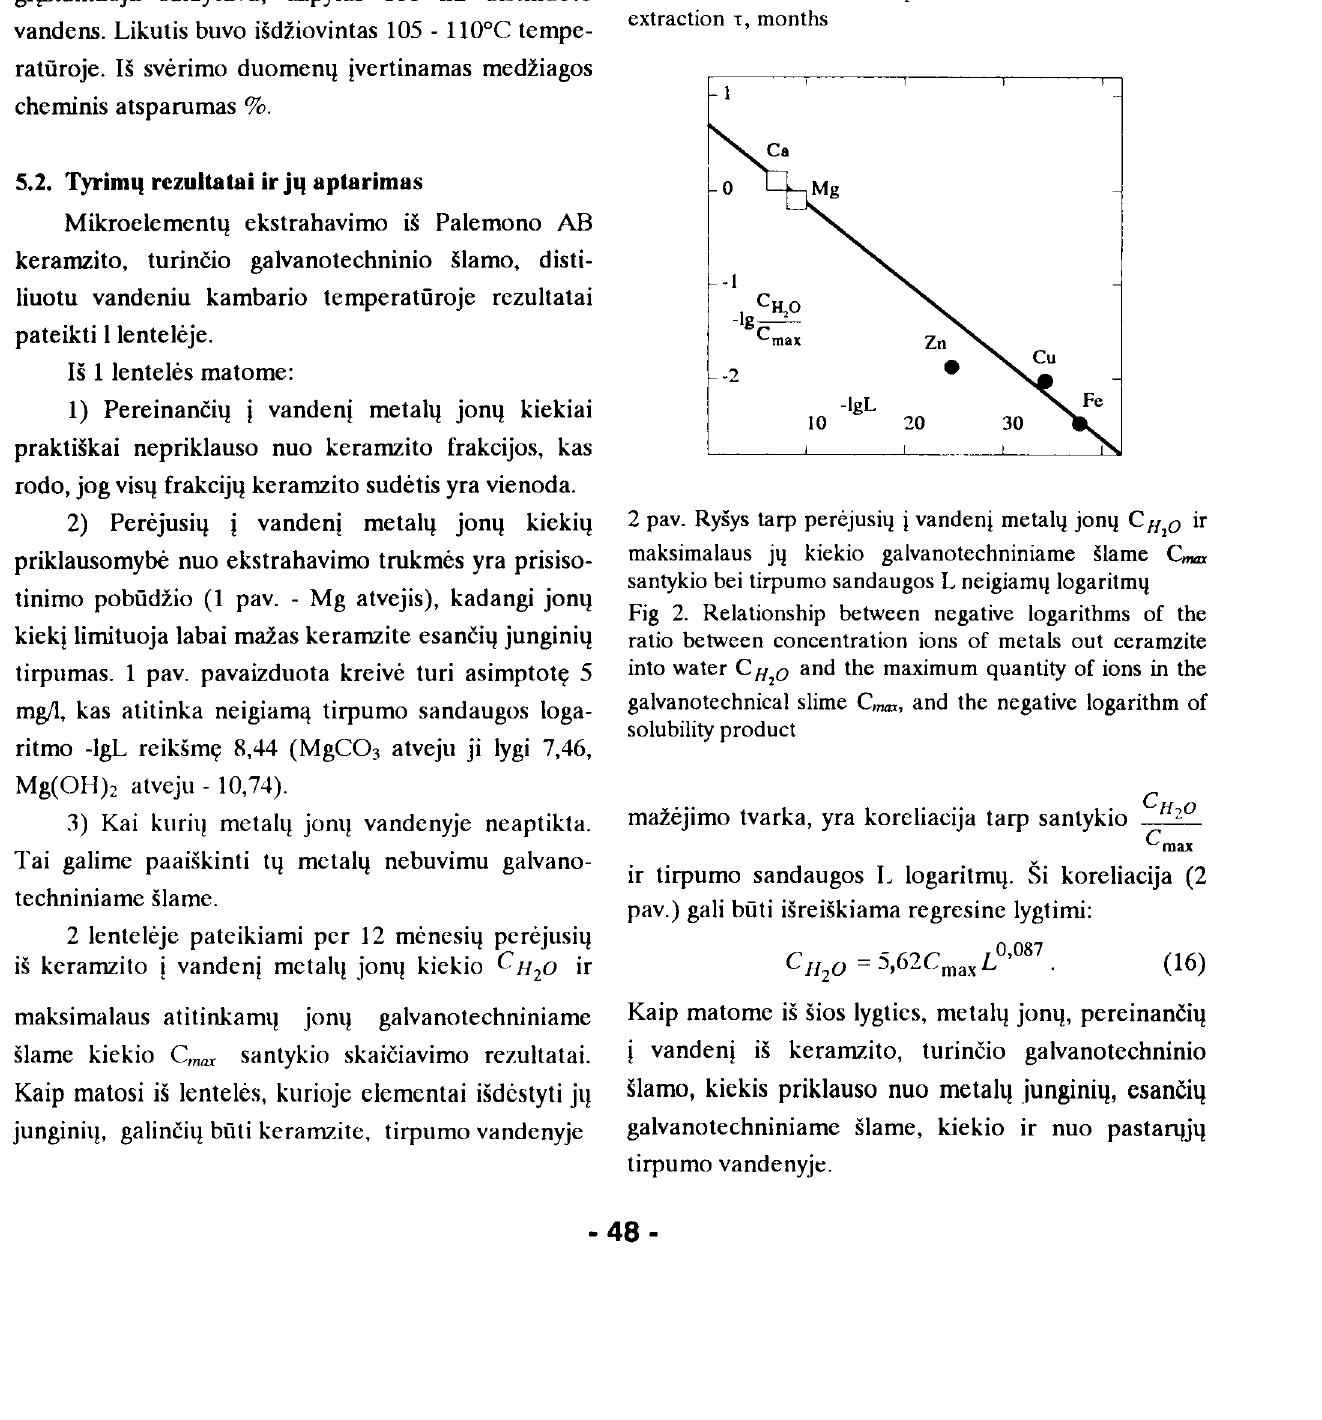
o, mg/1, from the length of 2